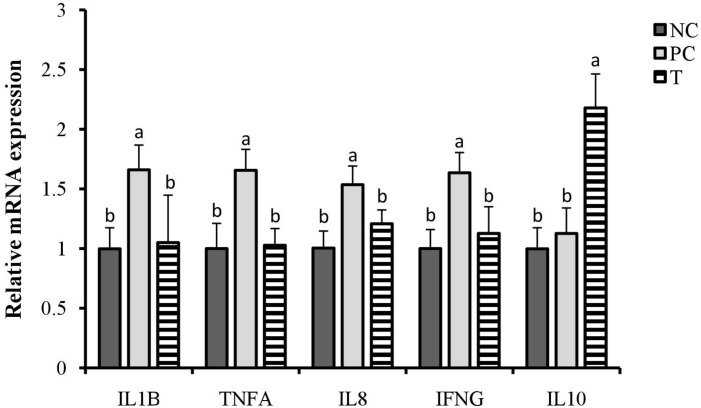
Effects of plant extracts (PE) from Flos Lonicerae in combination with Baikal Skullcap on the relative expression of ileal cytokines of laying hens at 3 days post S. pullorum infection. Error bars represent the standard deviation. a,bTreatments with different letters were significantly different (P < 0.05). NC, negative control (birds were free of challenge); PC, positive control (birds were challenged with S. pullorum at the end of week 4 of the experiment); T, treatment group (PC + plant extracts addition at 1000 mg/kg).